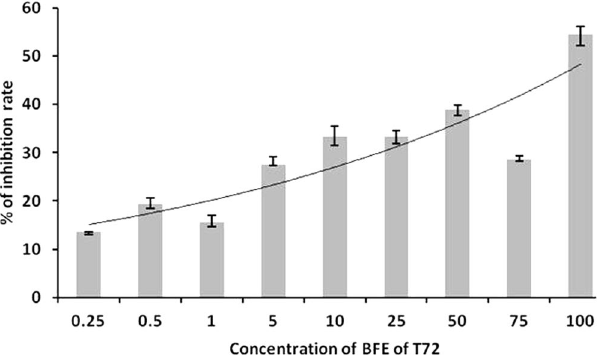
Figure 7. Effect of bioactive fungal metabolite (BFE) derived from T. harzianum strain CCTCC-RW0024 ( μ l/100 ml of PDA) on growth inhibition rate of FG.